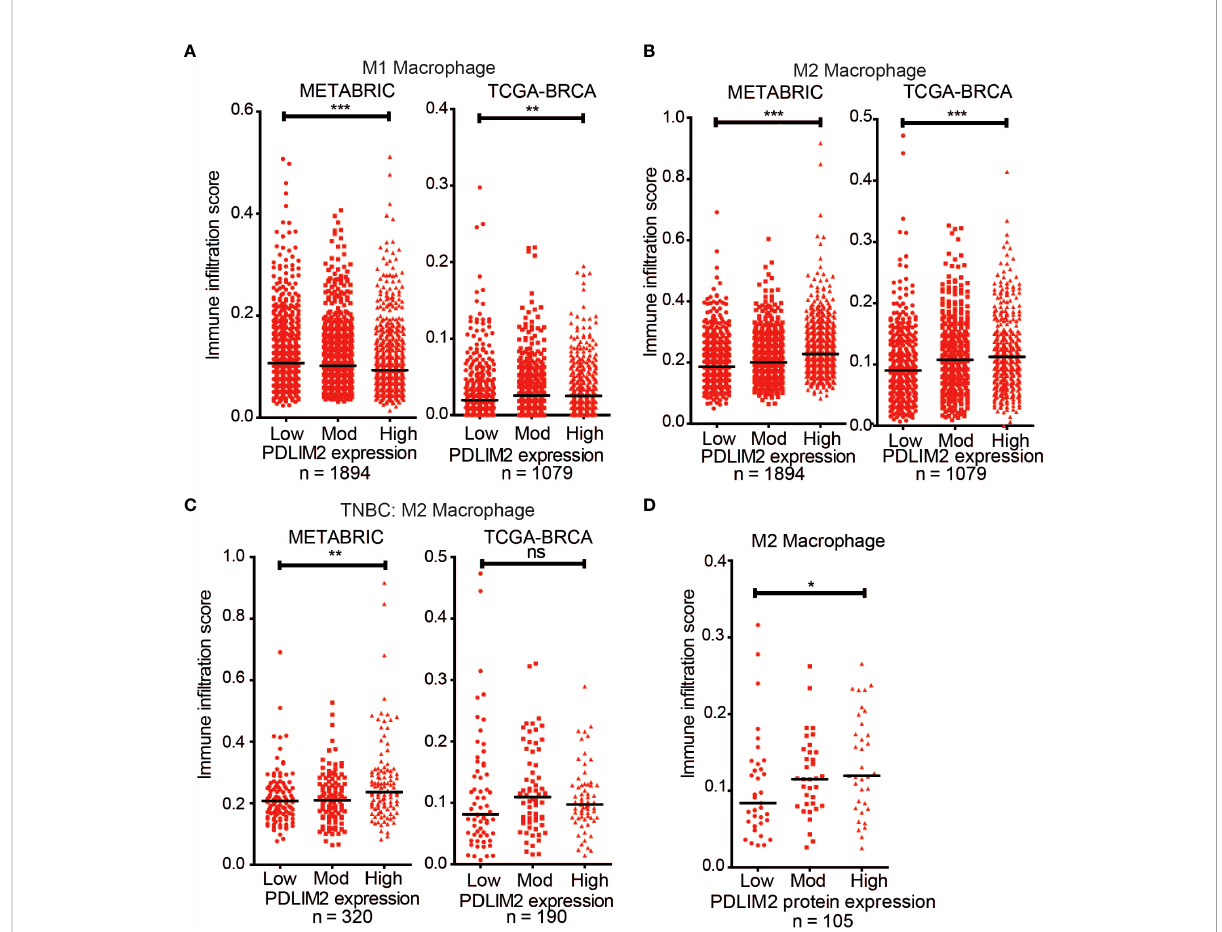
FIGURE 6 CIBERSORT deconvolution of METABRIC (n = 1894) and TCGA-BRCA (n = 1079) cohorts. Scatter plots of the immune in fi ltration estimation scores for (A) M1 macrophages and (B) M2 Macrophages were plotted using data generated by CIBERSORT. (B) Scatter plot of the M2 Macrophage in fi ltration estimation scores for the TNBC cases in the METABRIC (n = 320) and TCGA-BRCA (n =190) cohorts. (D) Scatter plot of M2 Macrophage estimation scores for TCGA-BRCA samples with proteomic data (n = 105). On all graphs the bar indicates median expression and statistical signi fi cance was assessed using a two-tailed Mann-Whitney test comparing PDLIM2 Low vs PDLIM2 High samples. *, P ≤ 0.05; **, P ≤ 0.01; ***, P ≤